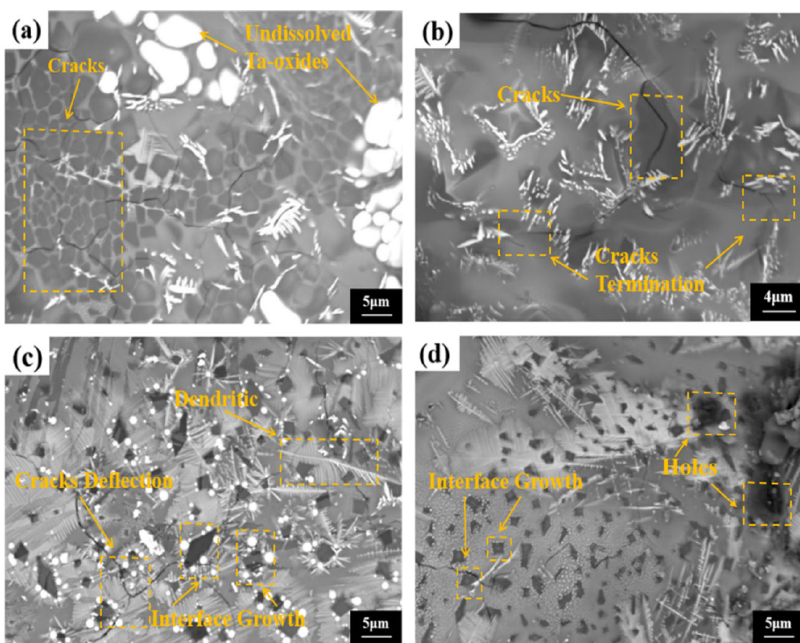
Fig. 14 SEM micrographs of the 40wt%TaB 2 –MoSi 2 –SiC/SiC coatings with different MoSi 2 contents after oxidation at 1500 ℃ for 100 h: (a) 0 wt% MoSi 2 , (b) 20 wt% MoSi 2 , (c) 40 wt% MoSi 2 ; (d) SEM micrograph of the 20wt%TaB 2 –60wt%MoSi 2 – SiC/SiC coating after oxidation at 1500 ℃ for 100